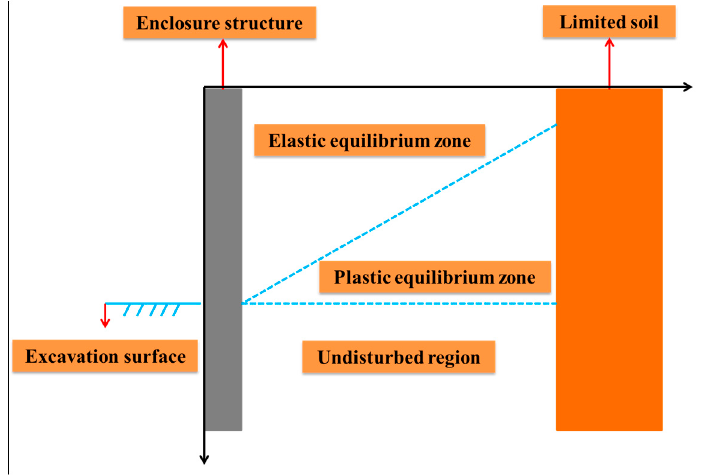
Figure 5. Strain state model of finite soil.